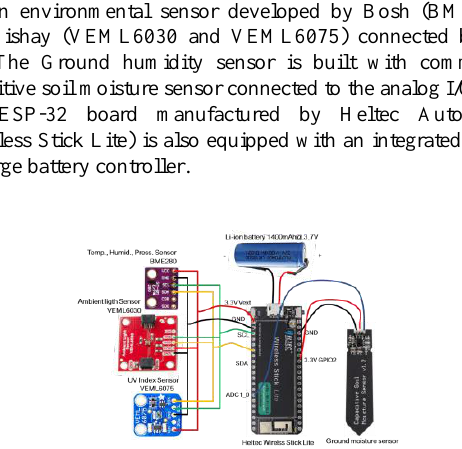
Figure 5. Sensor device connection diagram